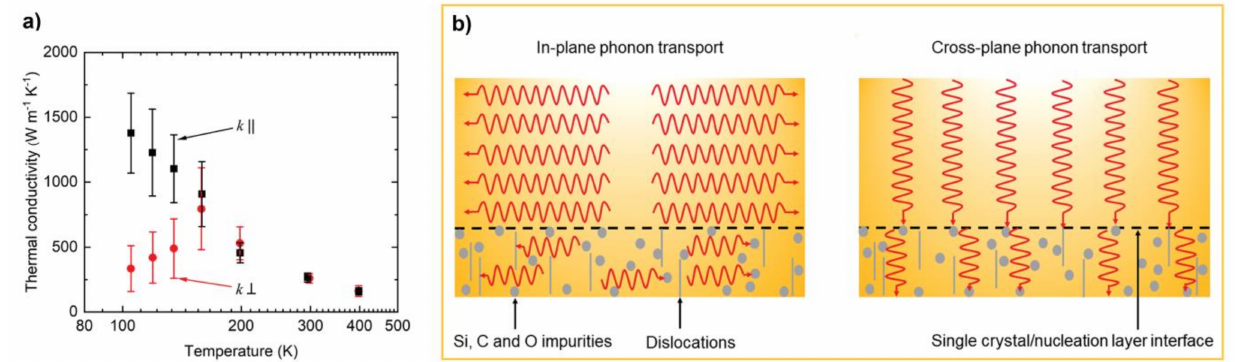
Figure 26. ( a ) Temperature-dependent (100–400 K) in-plane ( k (cid:107) ) and cross-plane ( k ⊥ ) thermal con- ductivities of a 3 µ m-thick AlN thin film grown on sapphire substrate; ( b ) schematic diagrams of the heat transport mechanism along the in-plane and cross-plane directions. Below the single crys- tal/nucleation layer interface, there exist lots of impurities and defects that can scatter cross-plane phonons. Reprinted with permission from [116]. Copyright {2018} American Chemical